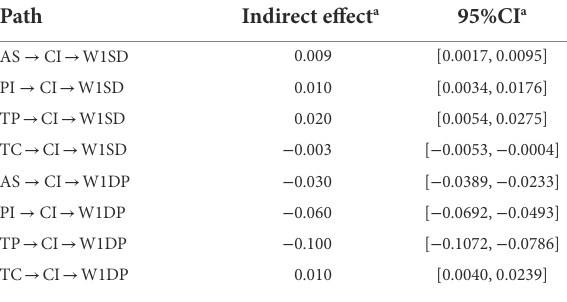
TABLE 4 Tests of indirect effects of collective integration in the hypothesized model by Monte Carlo approach of resampling (total sample, n =